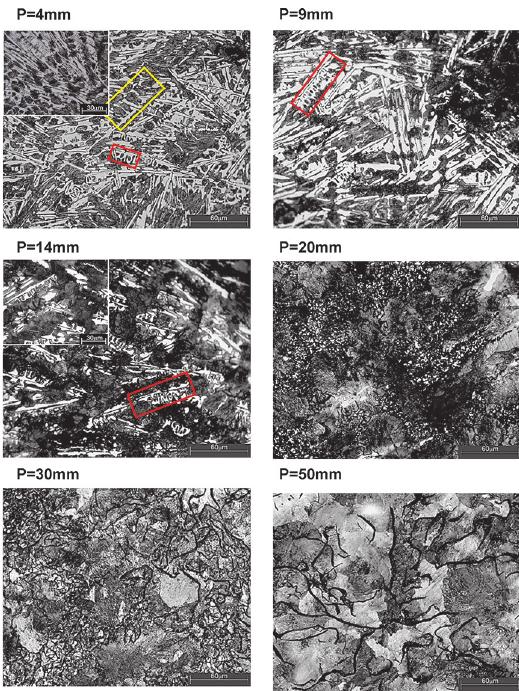
Figure 5: Typical microstructures of the directionally solidified cast iron from a number of different positions (P) along the length of the casting. P is the position from metal/mold interface. The inset images emphasize the occurrence of the eutectic dendrites.